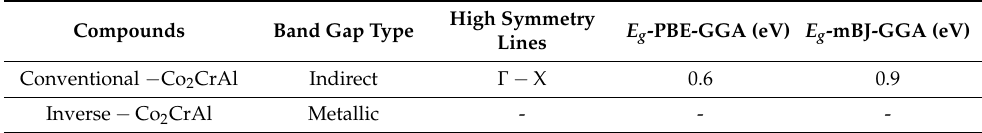
Table 5. The energy band gaps for conventional and inverse Co 2 CrAl compound using PBE-GGA and mBJ